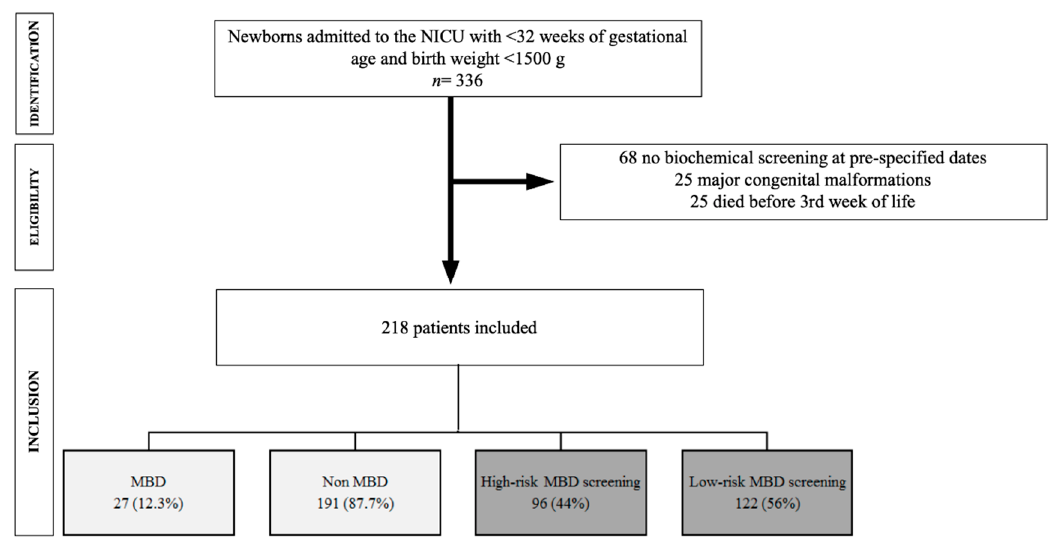
Figure 1. Flow chart depicting recruitment of cohort.